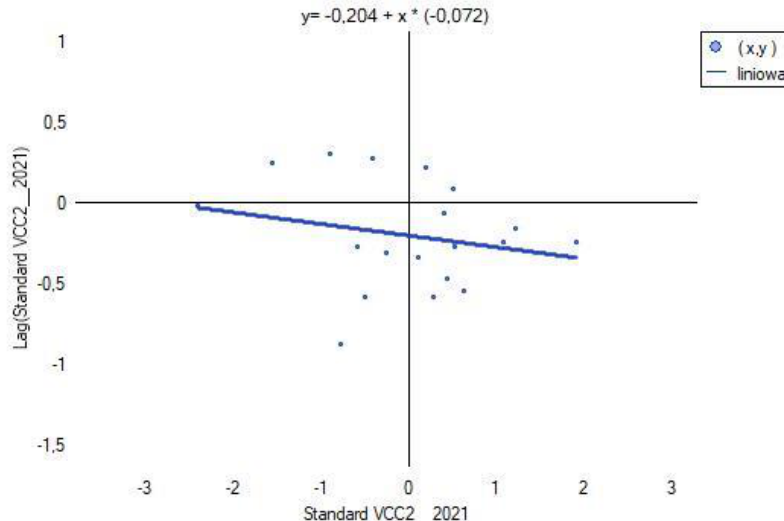
Figure 15. Chart of the global Moran’s index I for VCC1. Source: own study.